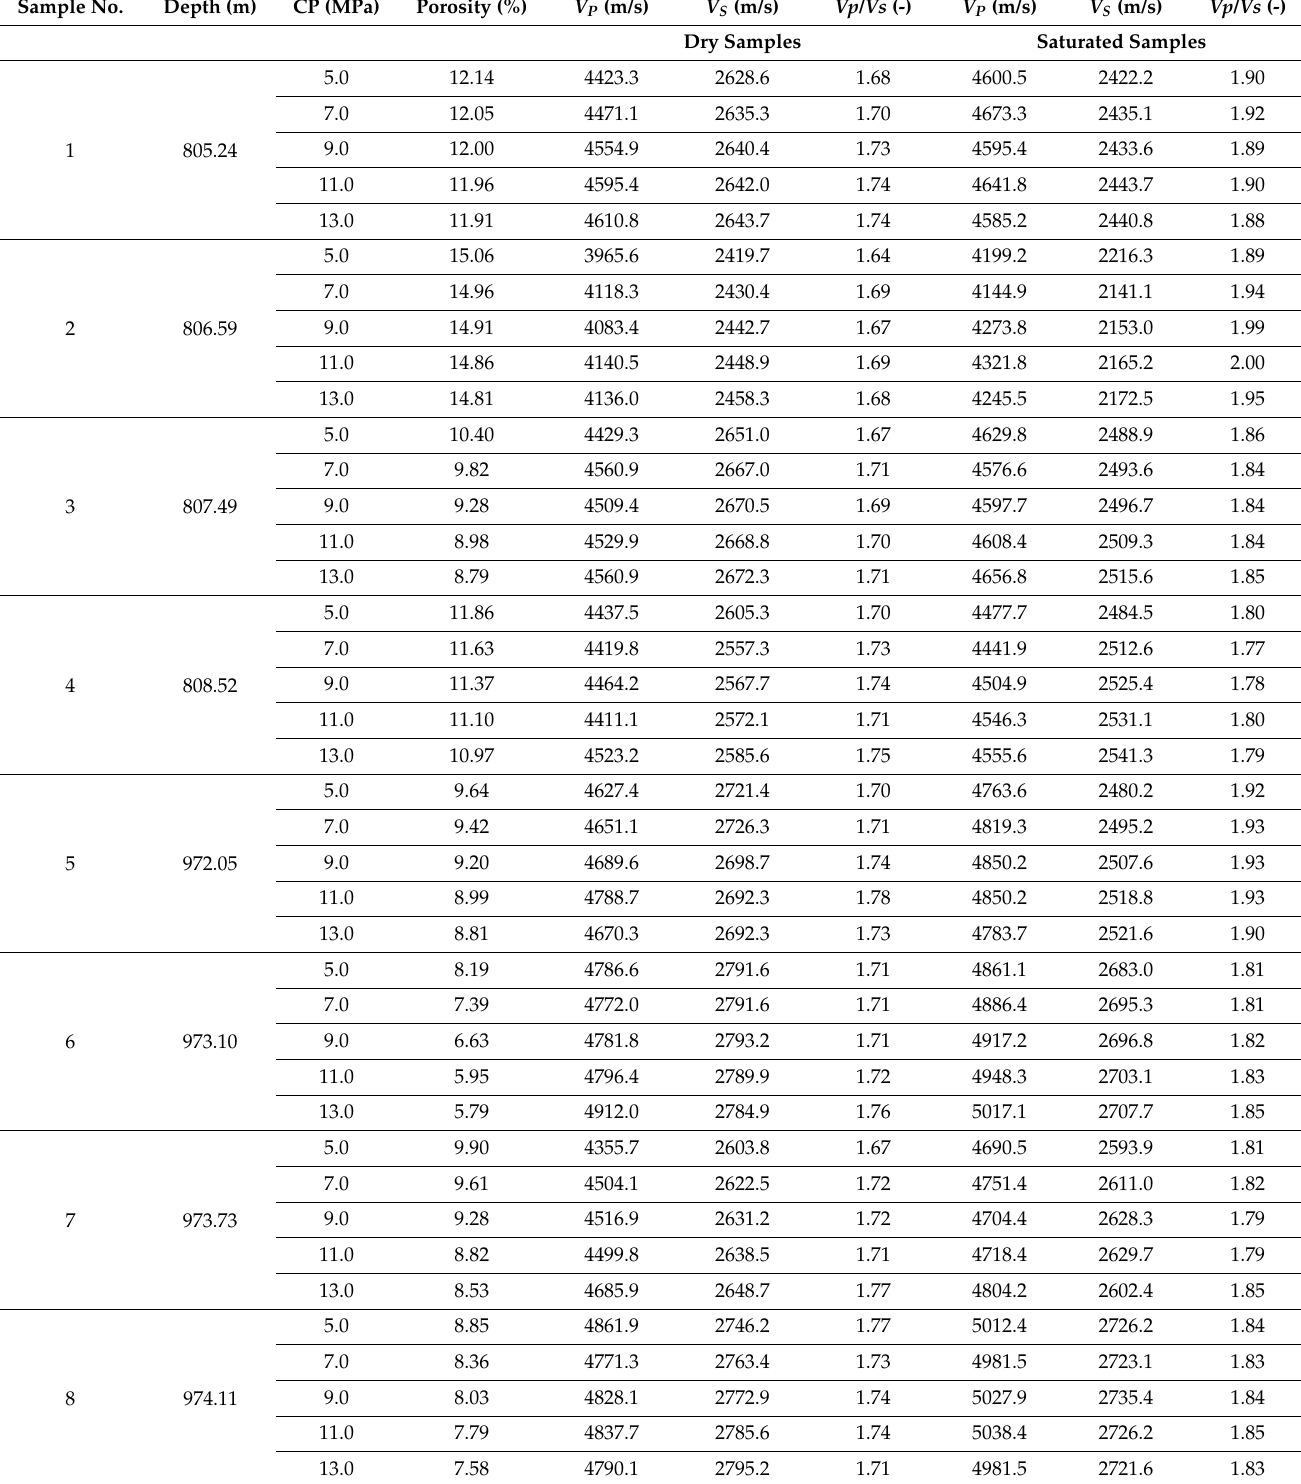
Table 1. Results of laboratory measurements in the Pannonian Basin limestone cores. Sample